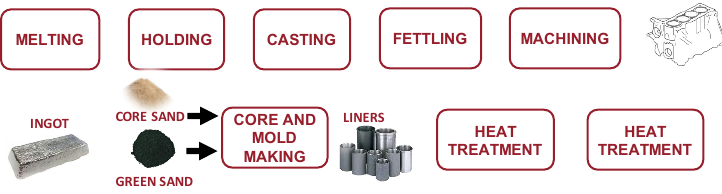
Figure 7. Process flow for Al-alloy engine block manufacturing.